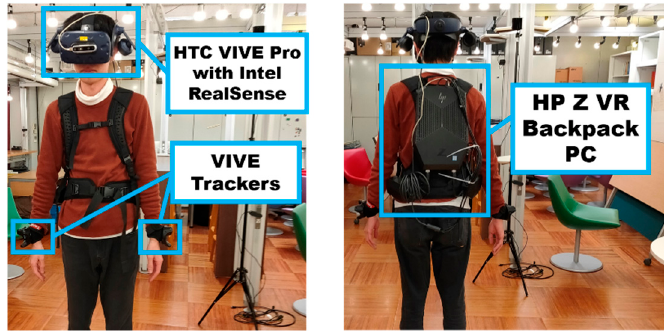
Figure 2. Equipment for experiment.